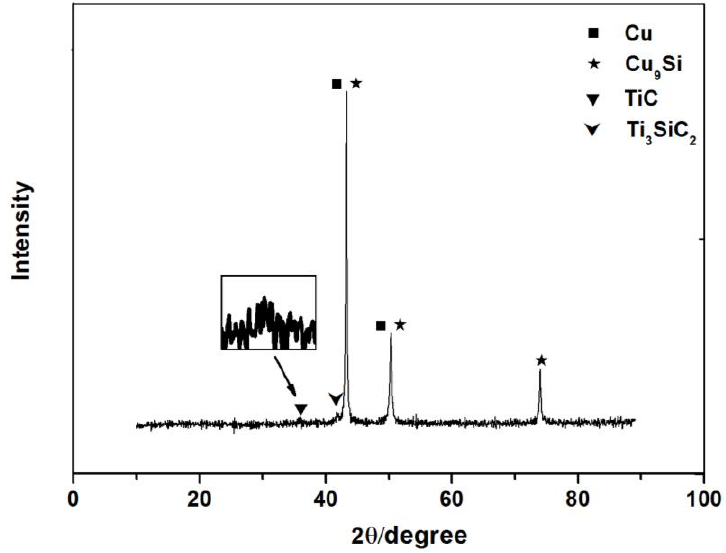
Figure 3. X-ray diffraction (XRD) results of Cu/Ti 3 SiC 2 /C/BN/GNPs nanocomposites.